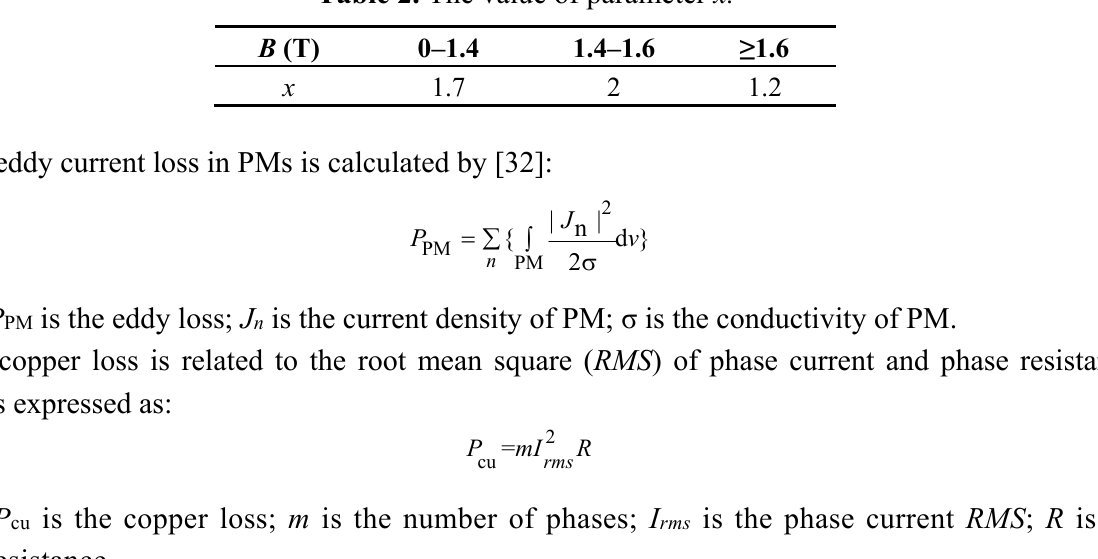
Table 2. The value of parameter